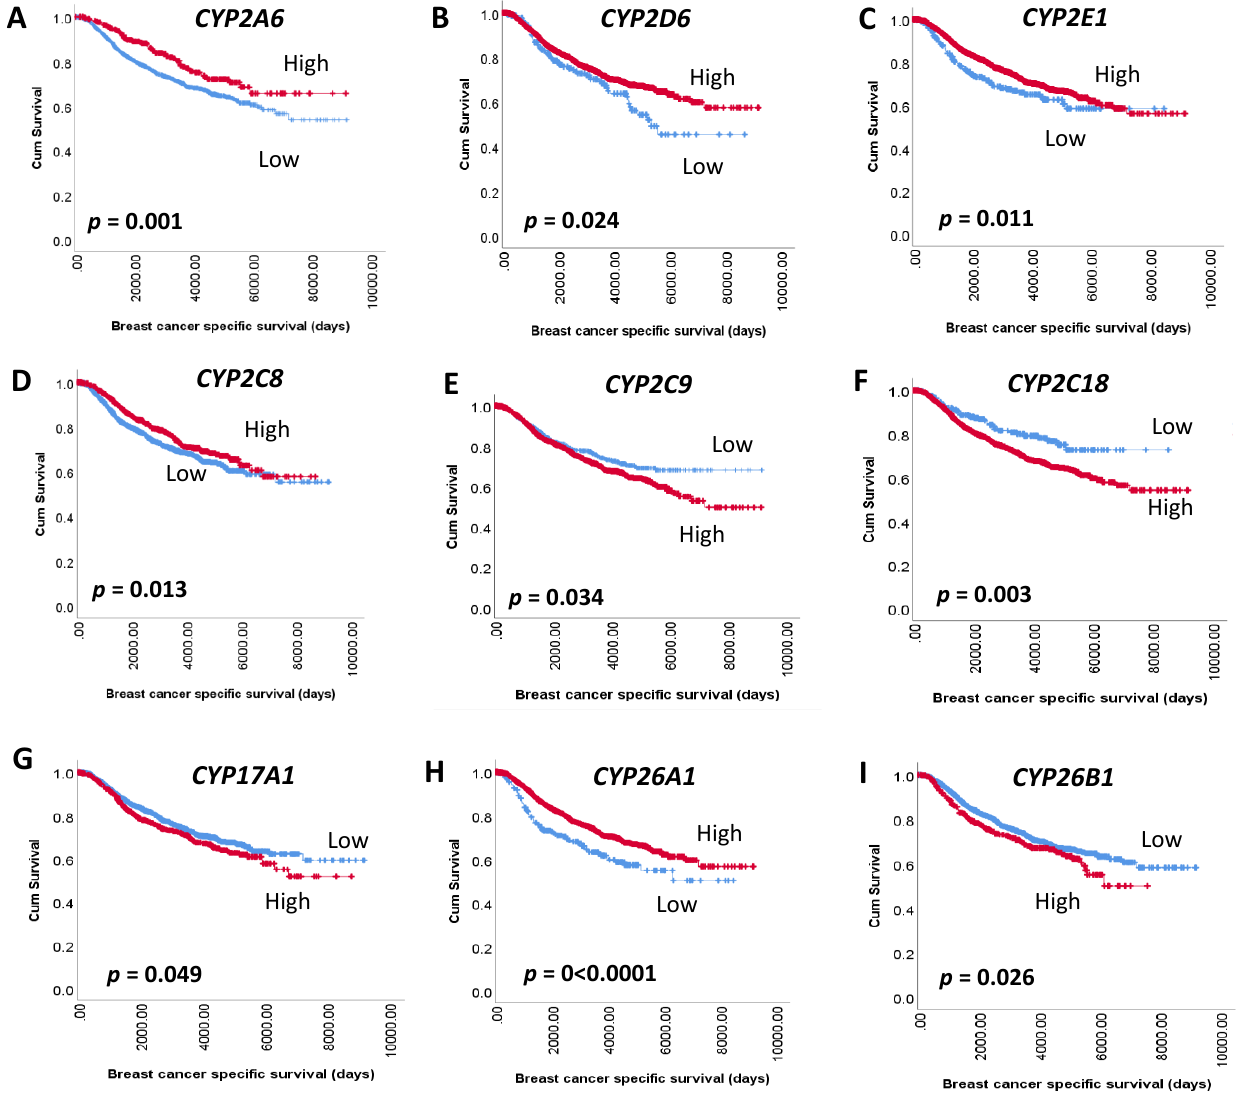
Figure 6. Kaplan–Meier survival analysis of CYP mRNA on breast cancer-specific survival. Survival curves showing the impact of low (blue line) and high (red line) mRNA expression: ( A ) CYP2A6 ( B ) CYP2D6 ( C ) CYP2E1 ( D ) CYP2C8 ( E ) CYP2C9 ( F ) CYP2C18 ( G ) CYP17A1 ( H ) CYP26A1 (I) CYP26B1 . Significance was determined using the log-rank test. Significant p -values (<0.05) are indicated in bold.